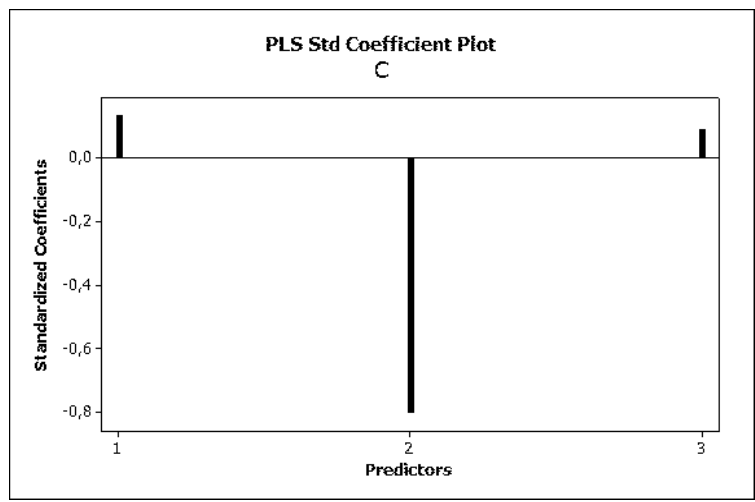
Figure 4. PLS standardized coefficient plots obtained for Equation (12) ( A ), Equation (13) ( B ) and Equation (14) ( C ).